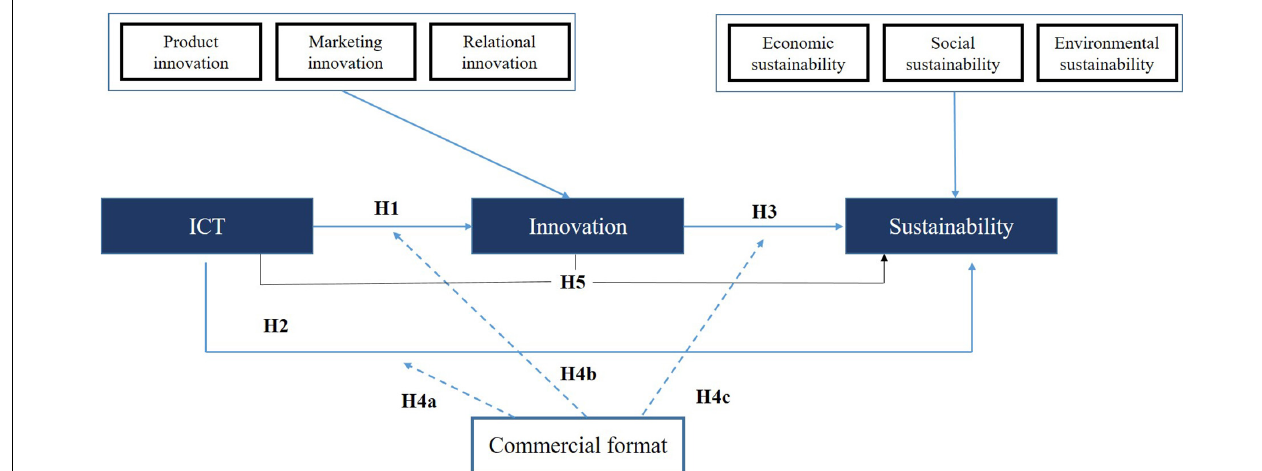
FIGURE 1 | Proposed research model.